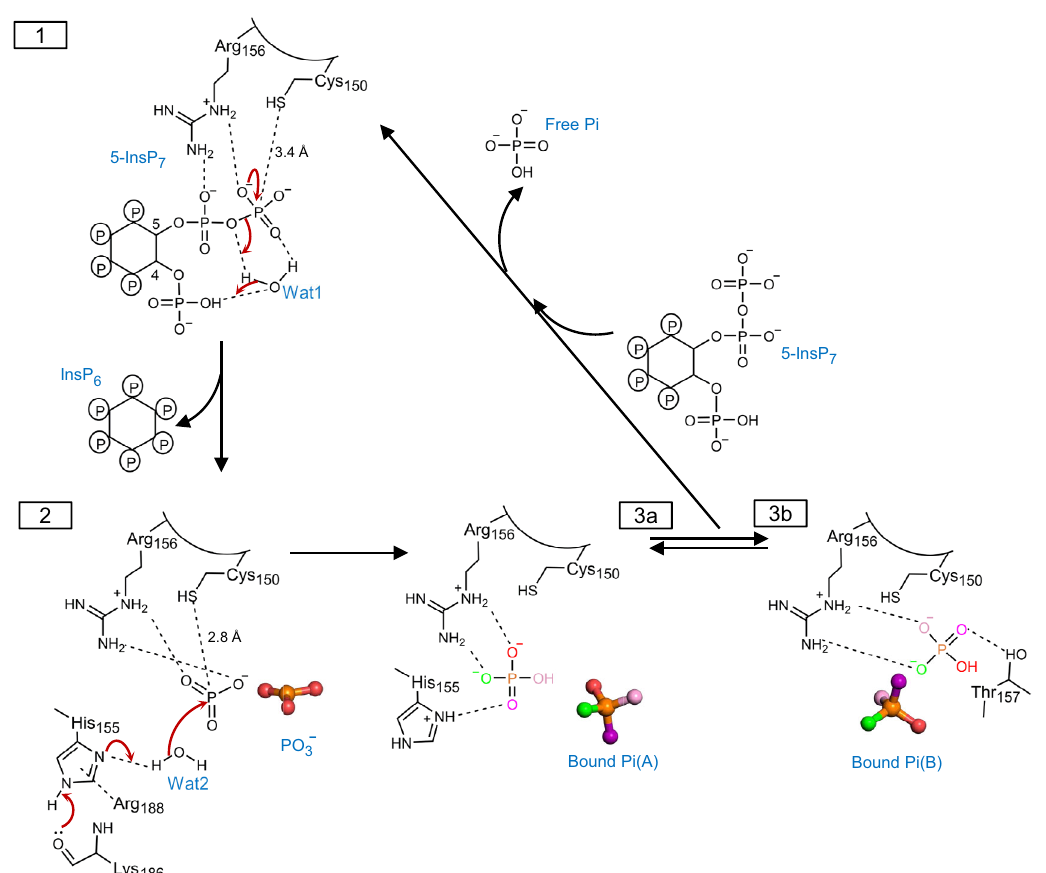
Fig. 7 Proposed relationship between structural snapshots for At PFA-DSP1 in the context of 5-InsP 7 hydrolysis. Key polar contacts are highlighted with black dashed lines. Coloring of oxygen atoms is only for illustrative purposes. State 1 depicts presumed canonical nucleophilic attack by Cys150 on the β - phosphate of enzyme-bound 5-InsP 7 . We presume a thiophosphate intermediate is formed, although we did not capture one in our crystals. Also shown is a water molecule (Wat1) that we postulate to shuttle a proton from the substrate ’ s 4-phosphate to the diphosphate ’ s bridging oxygen, with the release